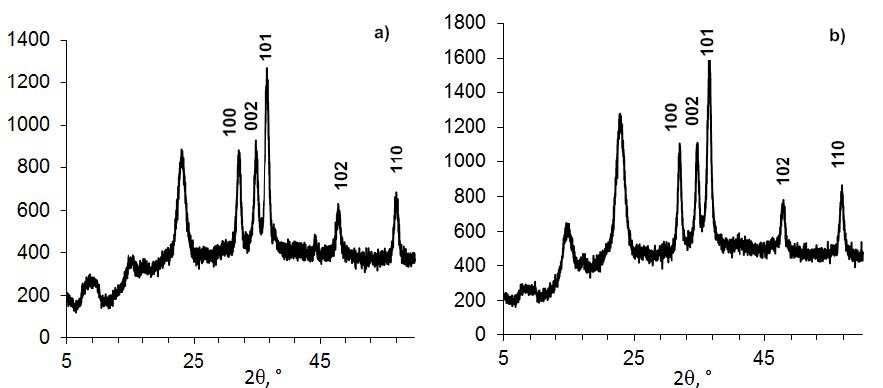
Figure 2. Powder XRD patterns of compositions (BC 0.5 g + ZnO NPs 0.15 g) samples, formed in different conditions in the presence of tris ( a ) or DDS-Na ( b ).